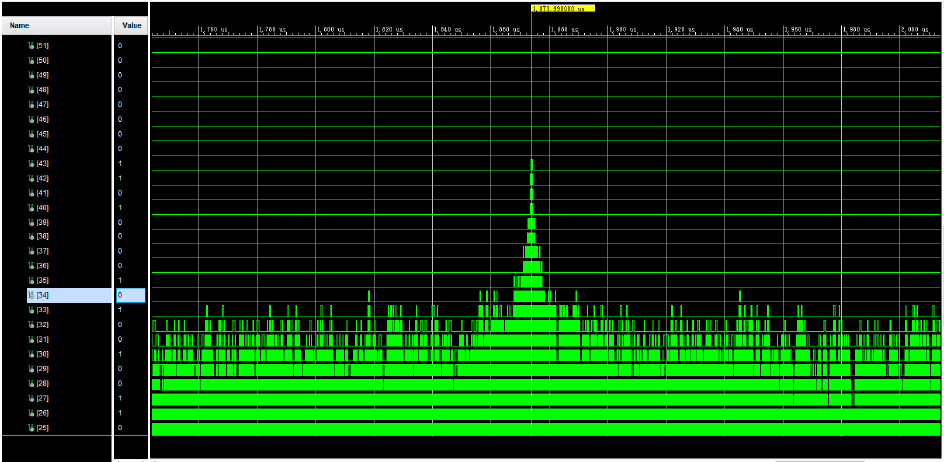
Figure 6. Correlation peak in simulation of preamble detection.